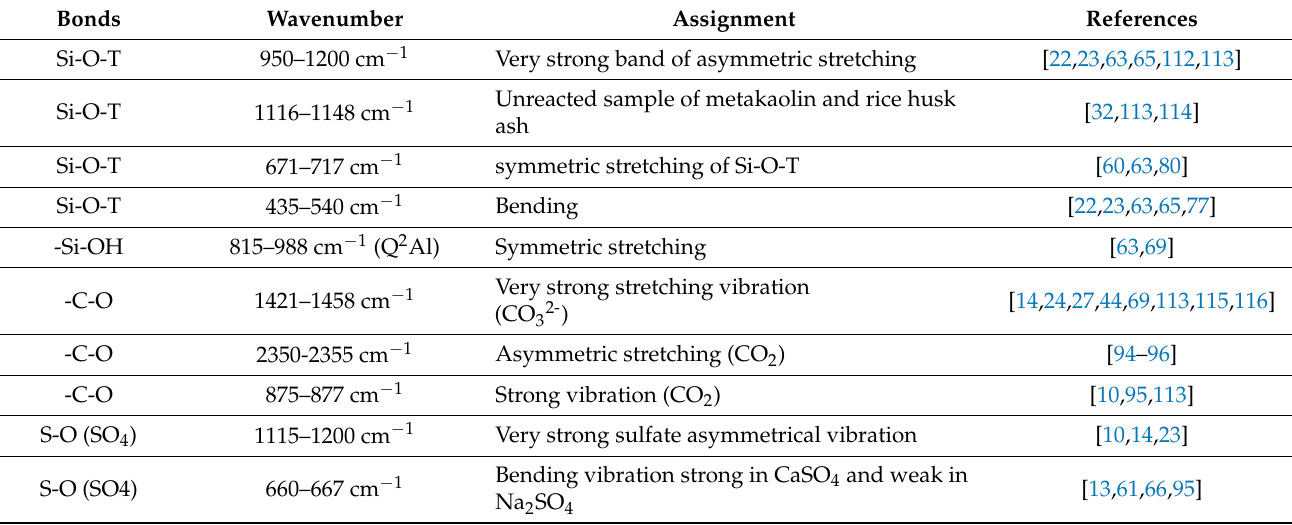
Table 1. Some of the significant bands in the FTIR spectra of cementitious